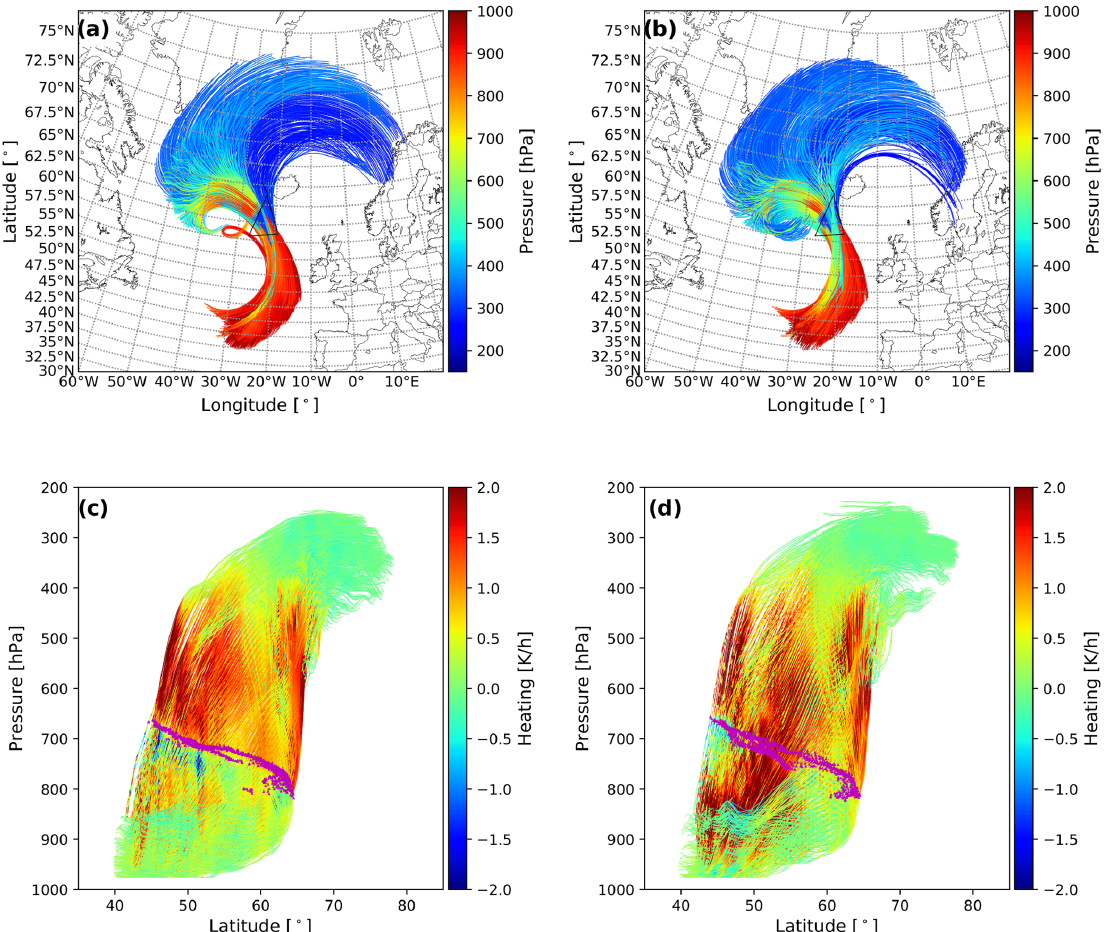
Figure 4. (a, b) Horizontal section of the pressure (shadings) along the warm conveyor belt trajectories crossing the Flight F7 for (a) B85 and (b) PCMT. (c, d) Meridional section of heating (shadings; 1st method of computation) along the warm conveyor belt trajectories crossing F7 for (c) B85 and (d) PCMT. Intersection with the iso-0 ◦ C is represented by purple